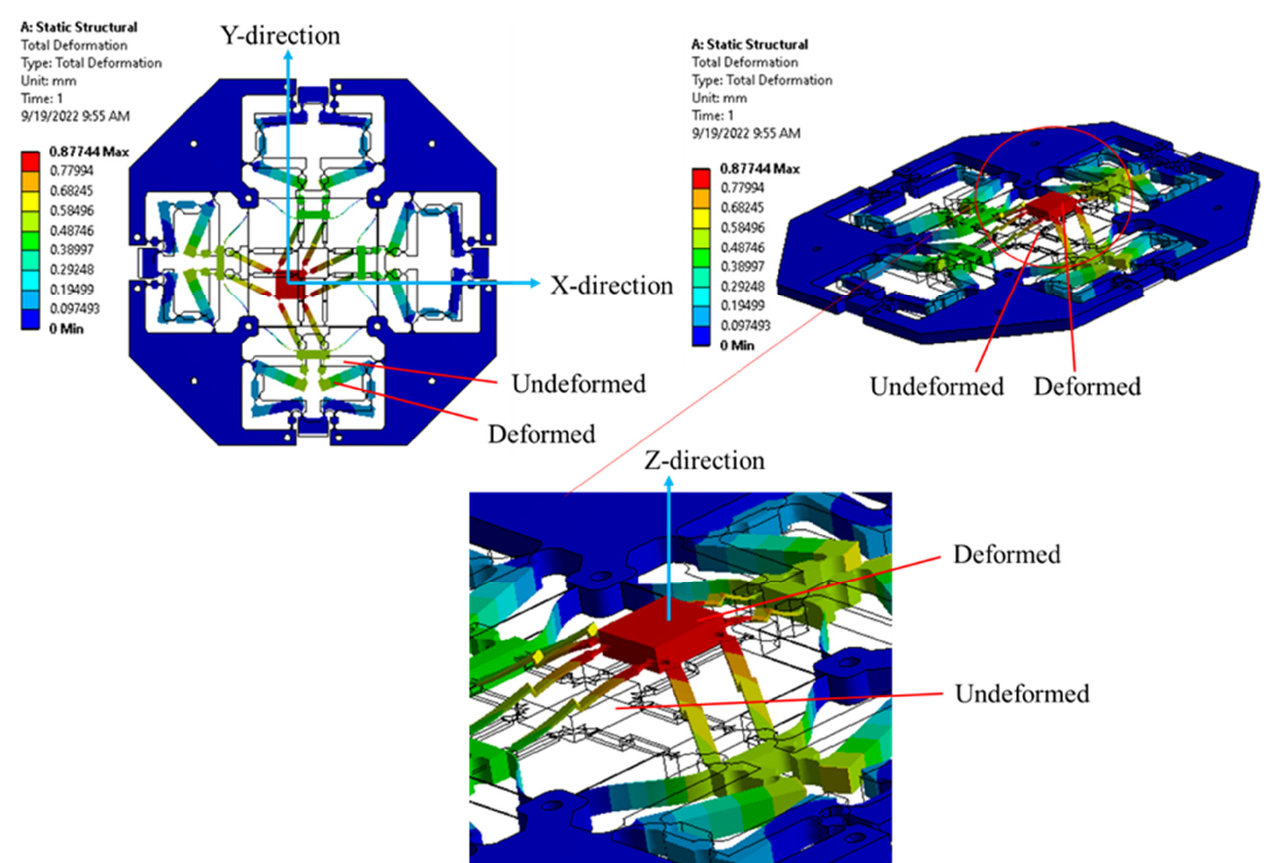
Figure 9. The deformed and undeformed topology of the proposed micropositioner are also provided in this figure.